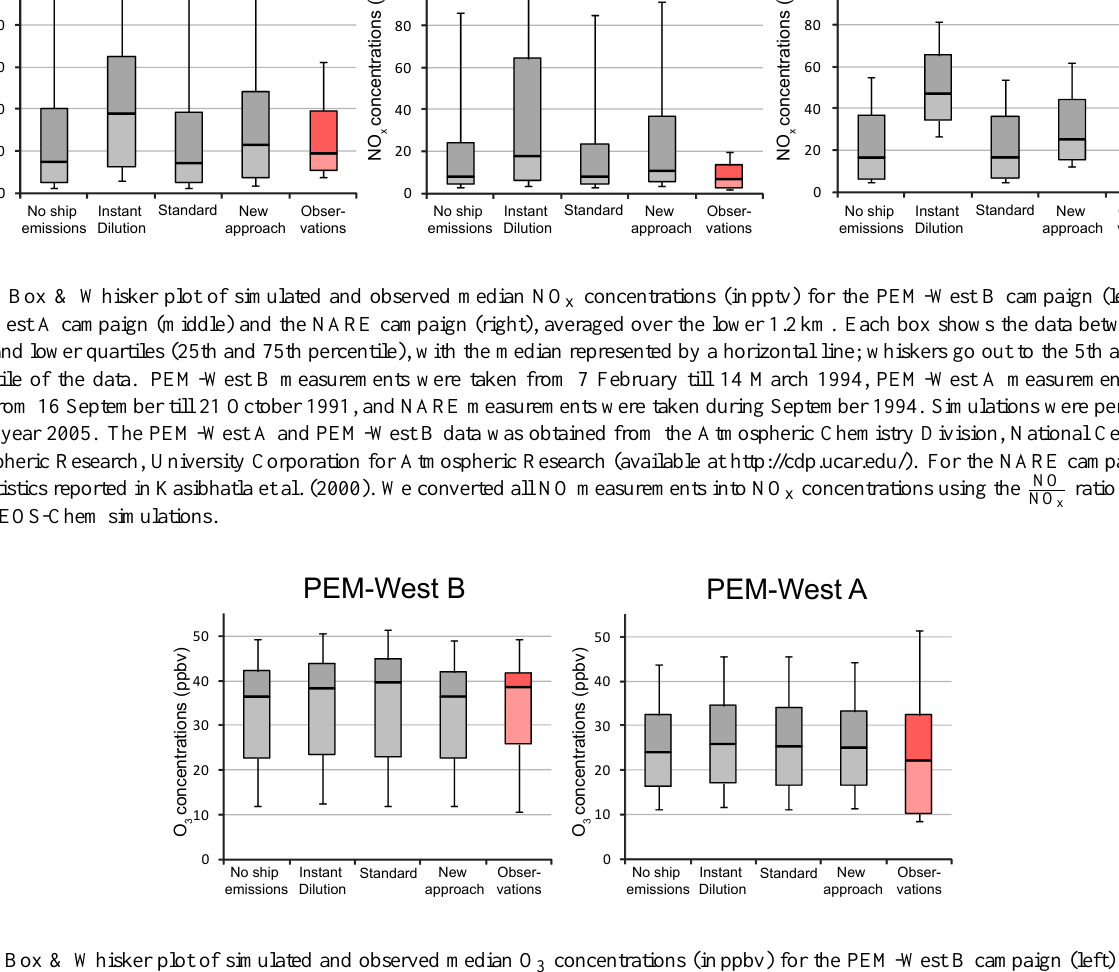
Fig. 5. Box & Whisker plot of simulated and observed median O 3 concentrations (in ppbv) for the PEM-West B campaign (left) and the PEM-West A campaign (right).